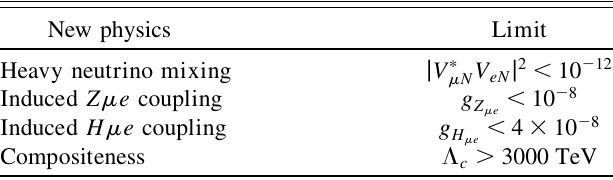
TABLE IV. Some examples of new physics probed by the nonobservation of (cid:3) ! e conversion at the 10 (cid:1) 16 level (from [88]).